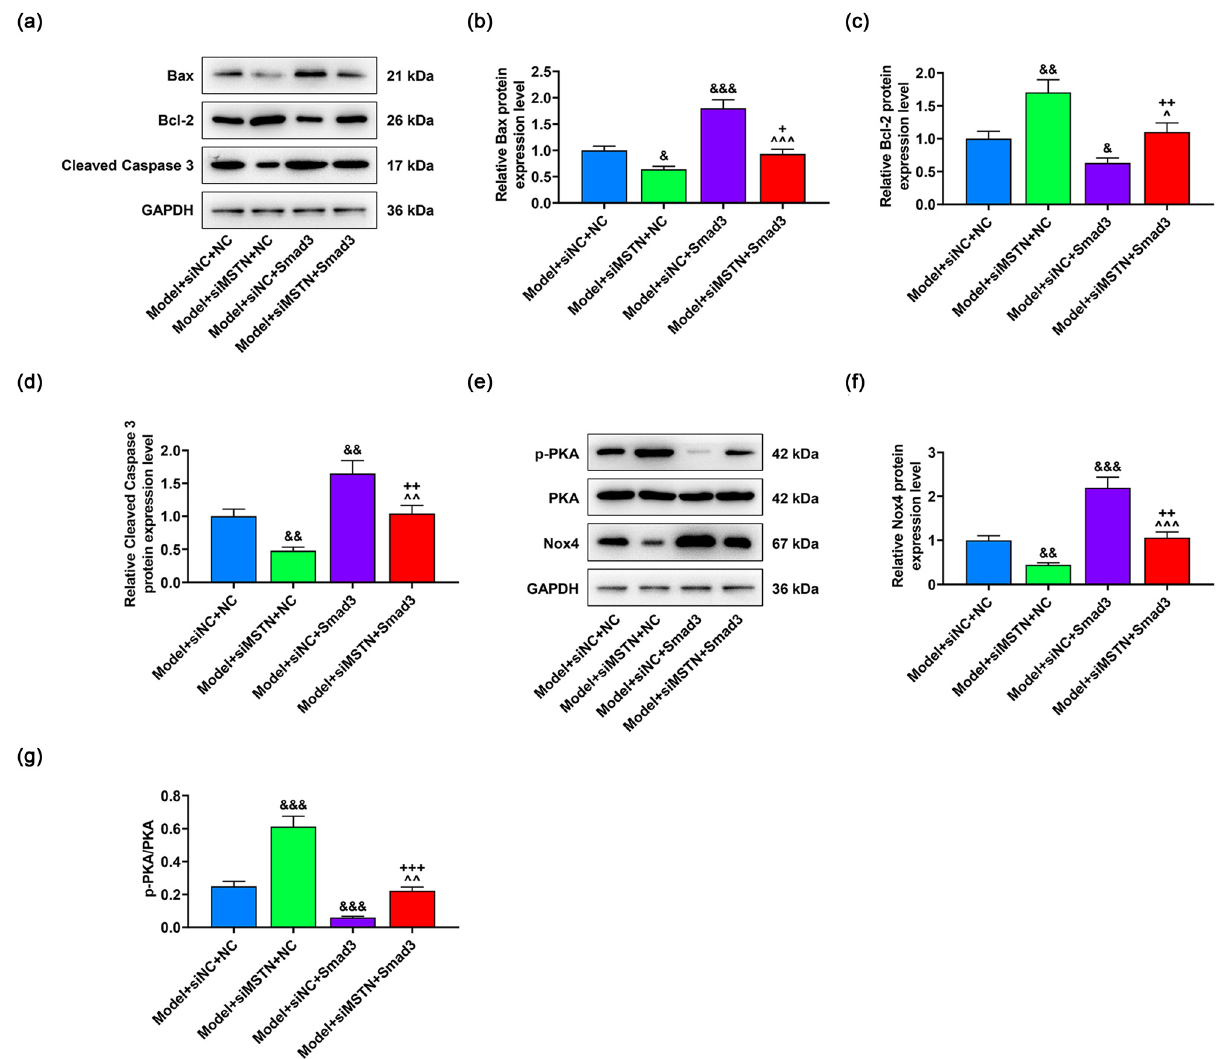
Figure 6: E ff ects of overexpressed Smad3 on the protein expressions related to apoptosis and PKA/Nox4 signaling pathway in MN model cells. AB8/13 cells were treated with Ang II ( 100 nmol/L ) to induce MN cell model, followed by the transfection of siNC or siMSTN and NC or Smad3 overexpression plasmid. ( a – d ) Expressions of apoptosis - related proteins in the model + siNC + NC, model + siMSTN + NC, model + siNC + Smad3, and model + siMSTN + Smad3 groups were determined by western blot, with GAPDH serving as the internal reference. ( e – g ) After the transfection, the PKA/Nox4 signaling pathway - related protein expressions were detected by western blot, with GAPDH acting as the internal reference. All experiments were repeated three times to obtain average values. The data are displayed as the mean ± SD of three independent experiments; & p < 0.05, && p < 0.01, &&& p < 0.001 vs Model + siNC + NC; + p < 0.05; ++ p < 0.01; +++ p < 0.001 vs Model + siMSTN + NC; ^ p < 0.05, ^^ p < 0.01, ^^^ p < 0.001 vs Model + siNC + Smad3. Abbreviation: MN, membranous nephropathy; MSTN, myostatin; p - PKA, phosphorylated - protein kinase A; Nox4, NADPH oxidase 4; GAPDH, glyceraldehyde - 3 - phosphate dehydrogenase; siMSTN, small interfering RNA targeting MSTN; siNC, siRNA negative